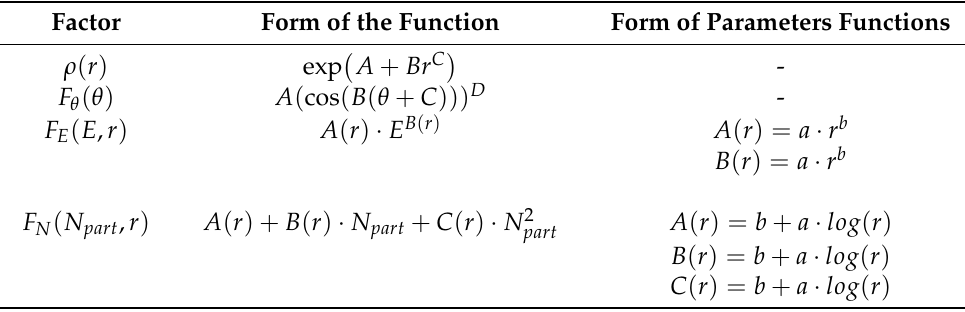
Table A1. Forms of functions used to define factors in ρ ( r , θ , E , N part )